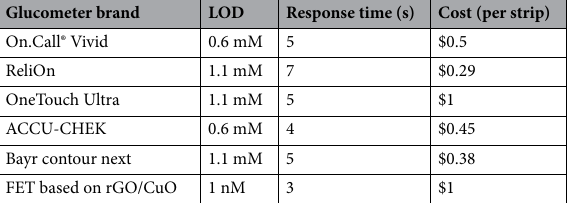
Glucometer brand